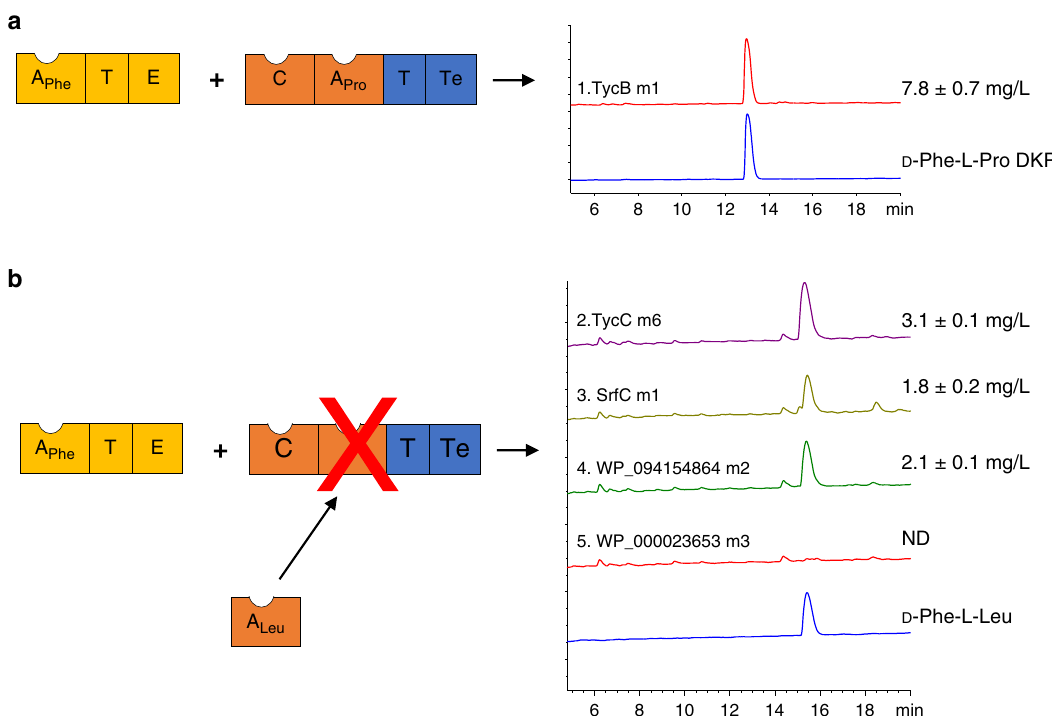
Fig. 5 Successful substitution of Leu-specifying A domains in the PheATE-ProCAT model system. a Schematic showing the domain arrangement of the PheATE/ProCATTe constructs used in this study and HPLC traces comparing the product made by an E. coli BAP1 strain expressing these constructs (1) relative to an analytical standard of D-Phe-L-Pro DKP (dark blue trace). b Schematic and HPLC traces for the products generated by four strains (2 – 5) bearing variants of ProCATTe in which the Pro-specifying A domain had been substituted by a Leu-specifying A domain. Strains 2, 3 and 4 show a peak corresponding to an analytical standard of D-Phe-L-Leu (dark blue trace) ( n = 3 independent experiments and data are presented as the mean yield ± SD). Masses of the expected products were veri fi ed using HR-ESI-MS (Supplementary Fig. S14). Source data are provided as a Source Data fi